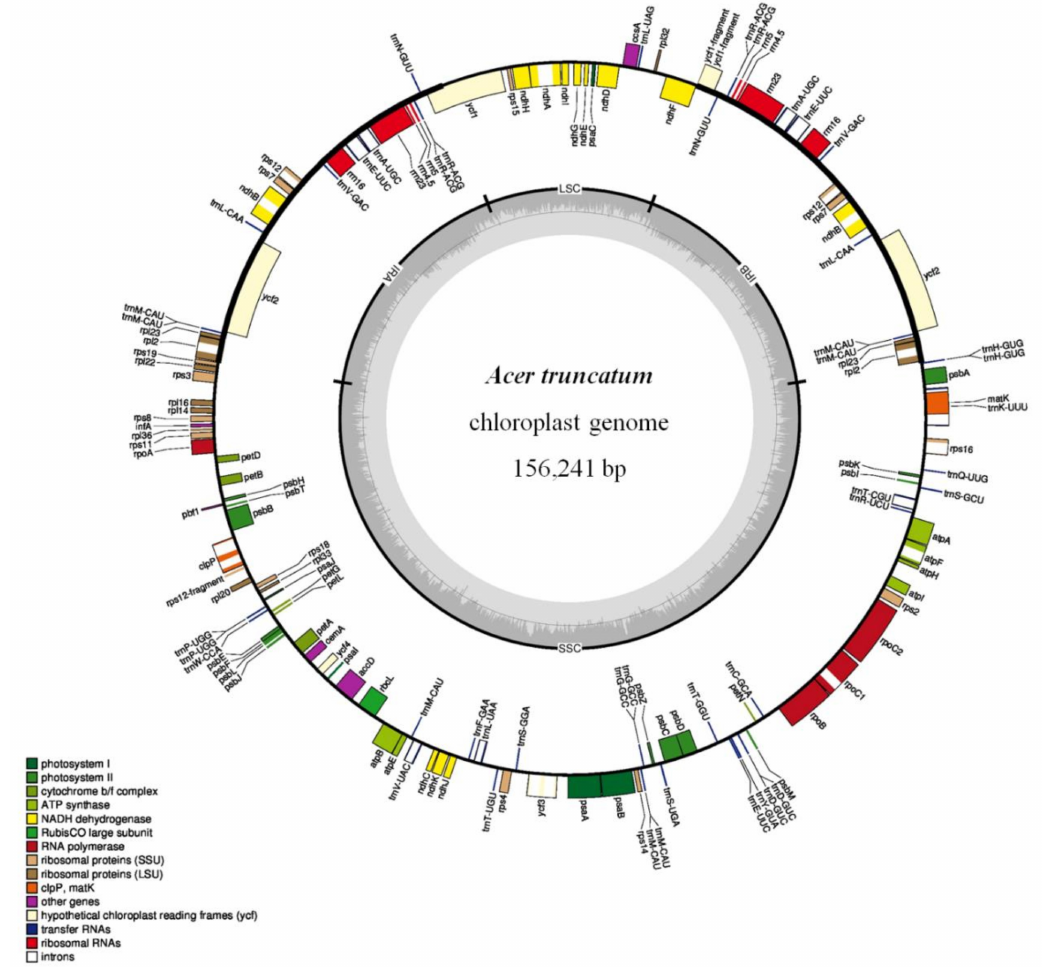
Figure 5. Physical map of the circular chloroplast genome of Acer truncatum